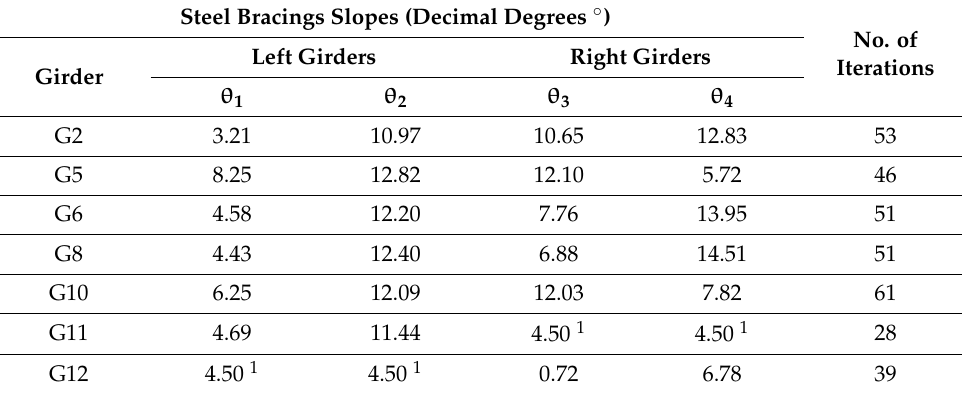
Table 2. Results of the optimization procedure to determine the slopes of the steel bracings.